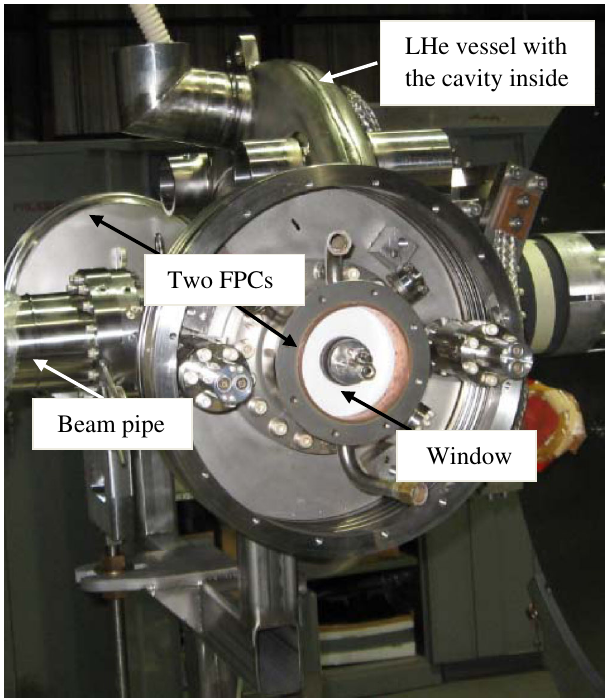
FIG. 1. BNL SRF gun with two opposing FPCs